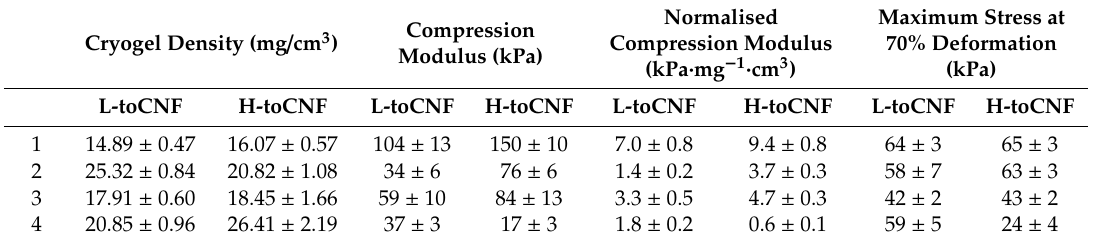
Table 5. Mechanical properties of to-CNF cryogels of different compositions.